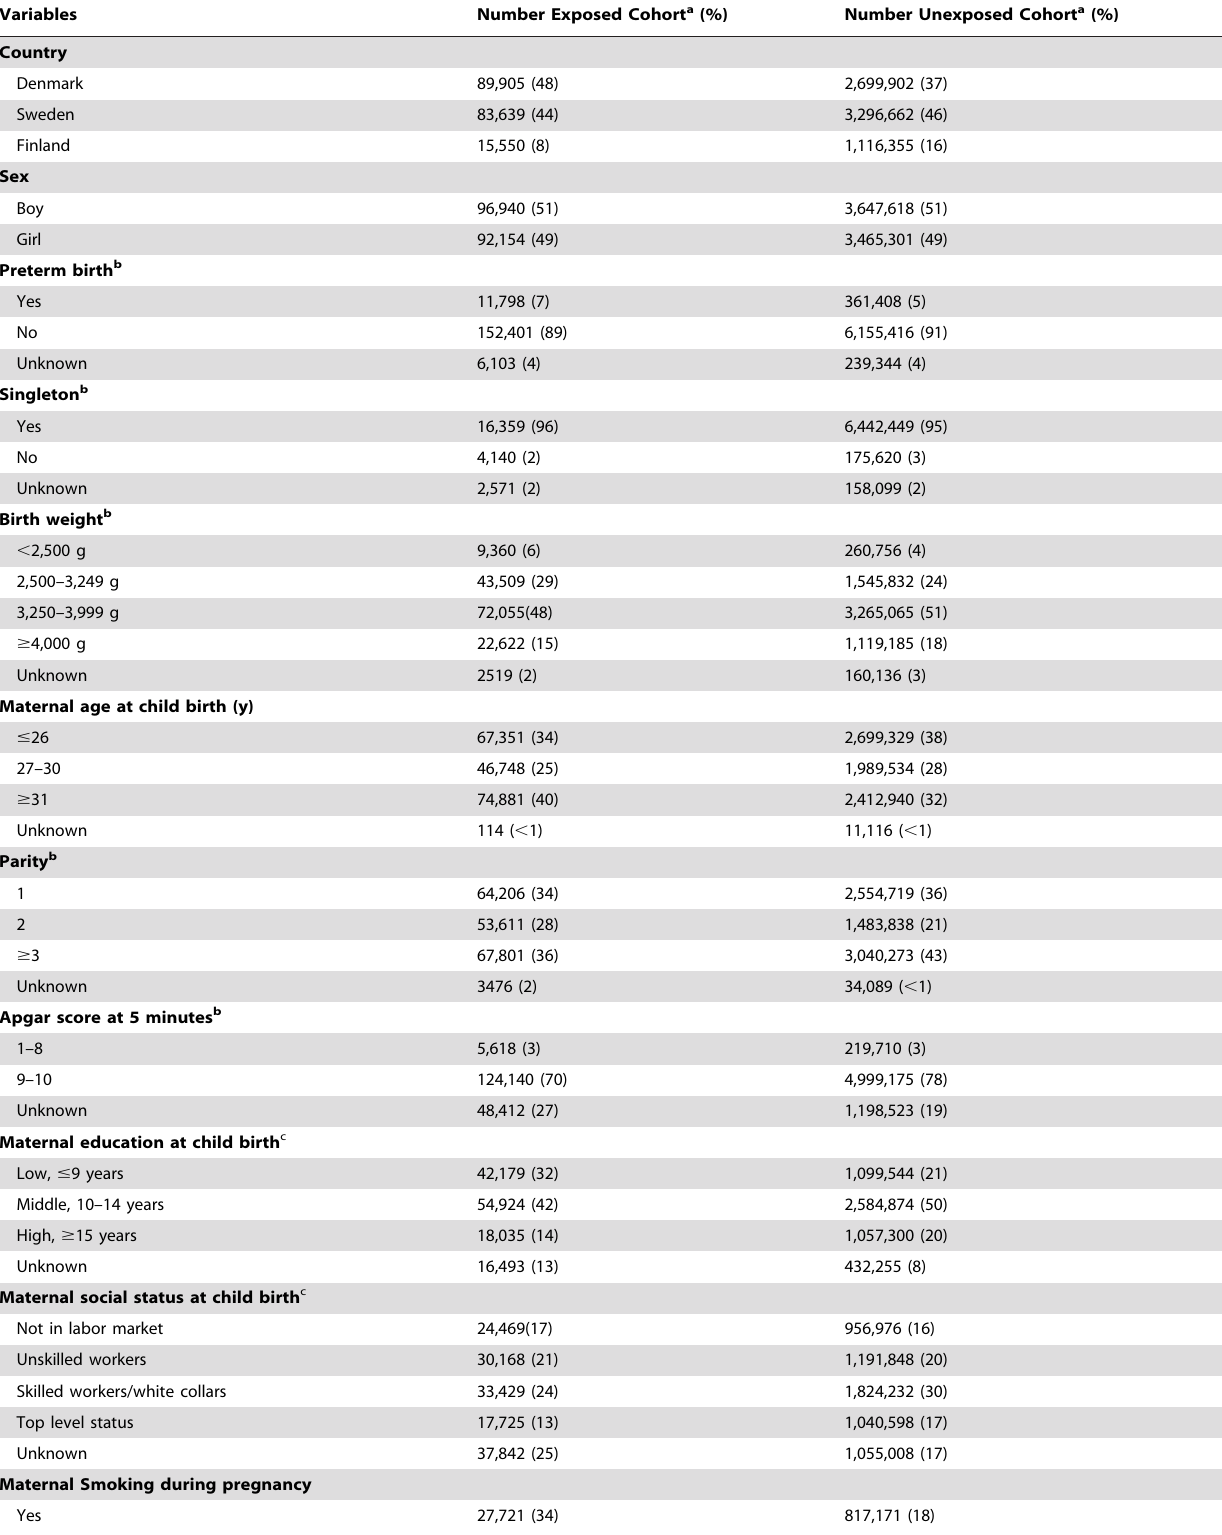
Table 1. Characteristics of the exposed and unexposed